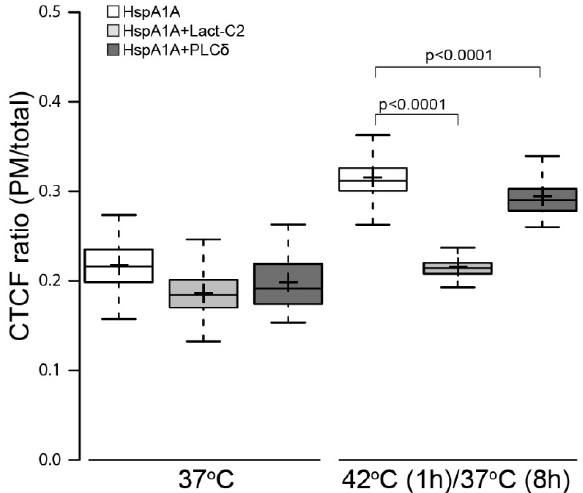
Figure 3. The PM-localization of HspA1A is inhibited by the removal of phosphatidylserine (PS) (presence of Lact-C2), but it is minimally affected by the removal of PI(4,5)P 2 (presence of PLC- δ -PH). The quantification of the corrected total cell fluorescence (CTCF) as a ratio between the total GFP- HspA1A fluorescence of the plasma membrane and the rest of the cell is presented for the different conditions used. Center lines show the medians; box limits indicate the 25th and 75th percentiles as determined by R software; whiskers extend 1.5 times the interquartile range from the 25th and 75th percentiles; crosses represent sample means. The experiment was repeated three times and the number of cells used to generate each boxplot was (from left to right) n = 48, 44, 26, 41, 52, 34.